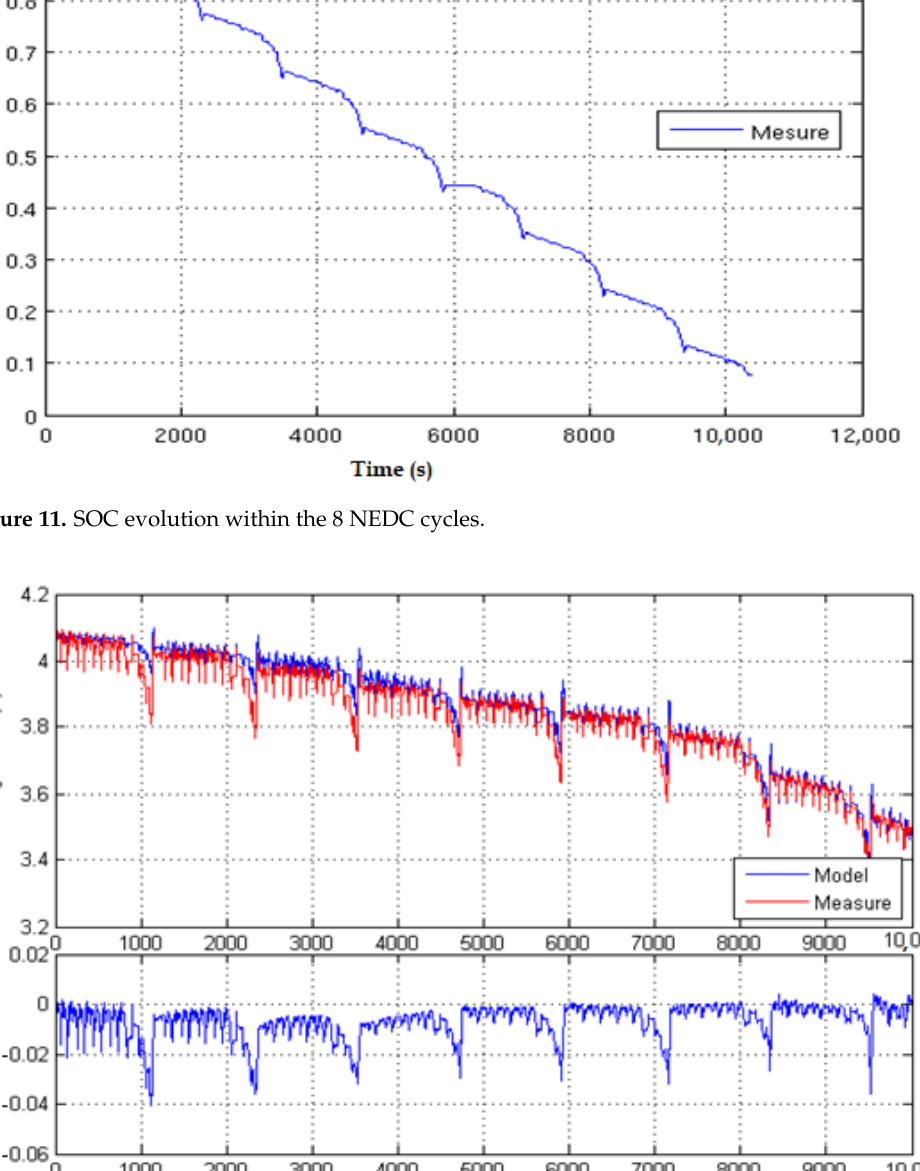
Figure 12. Cell voltages (measurement and Rint model) and relative error during the 8